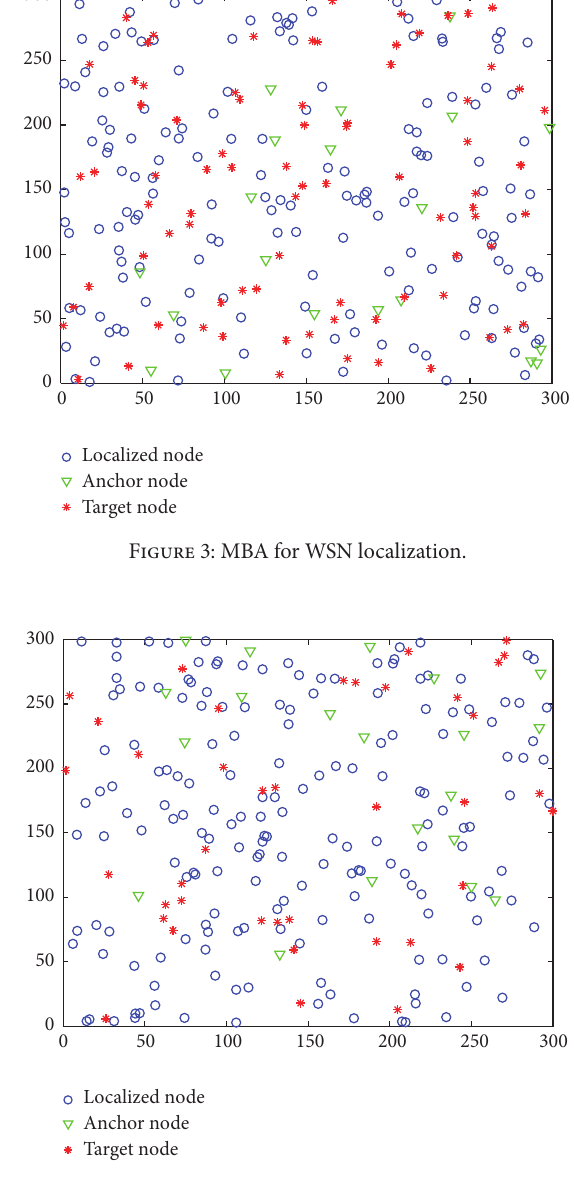
Figure 4: GWO for WSN